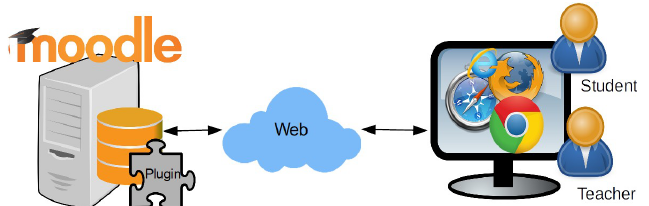
Figure 2. Classic architecture with